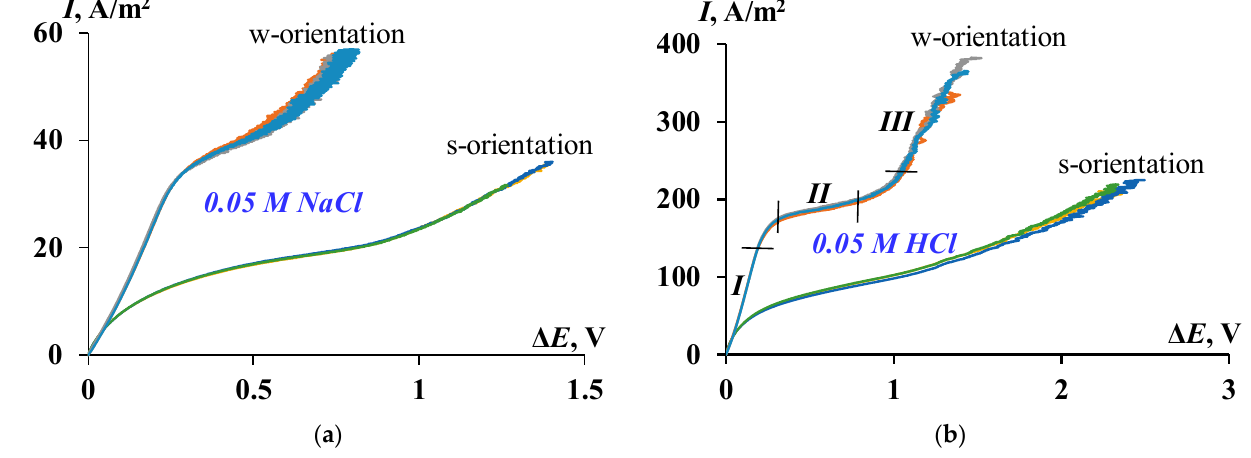
Figure 2. CVCs of bilayer MF-4SC/PTMSP membrane in 0.05 M NaCl ( a ) and HCl ( b ) electrolyte solutions. s-orientation-thin PTMSP layer is oriented towards anode; w-orientation-thick MF-4SC layer is oriented towards anode; I-ohmic region; II-limiting current plateau region; III-overlimiting region.